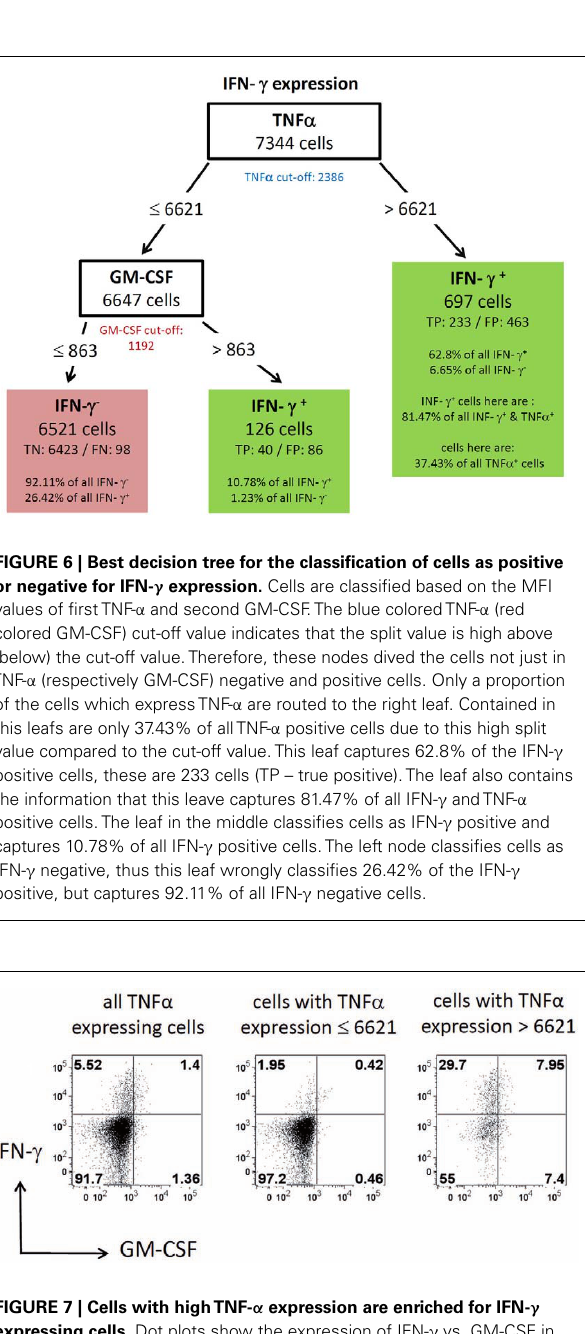
it can be concluded that especially a high expression of TNF- α is associated with the expression of IFN- γ . Routing down the tree of IFN- γ further, the next node contained GM-CSF